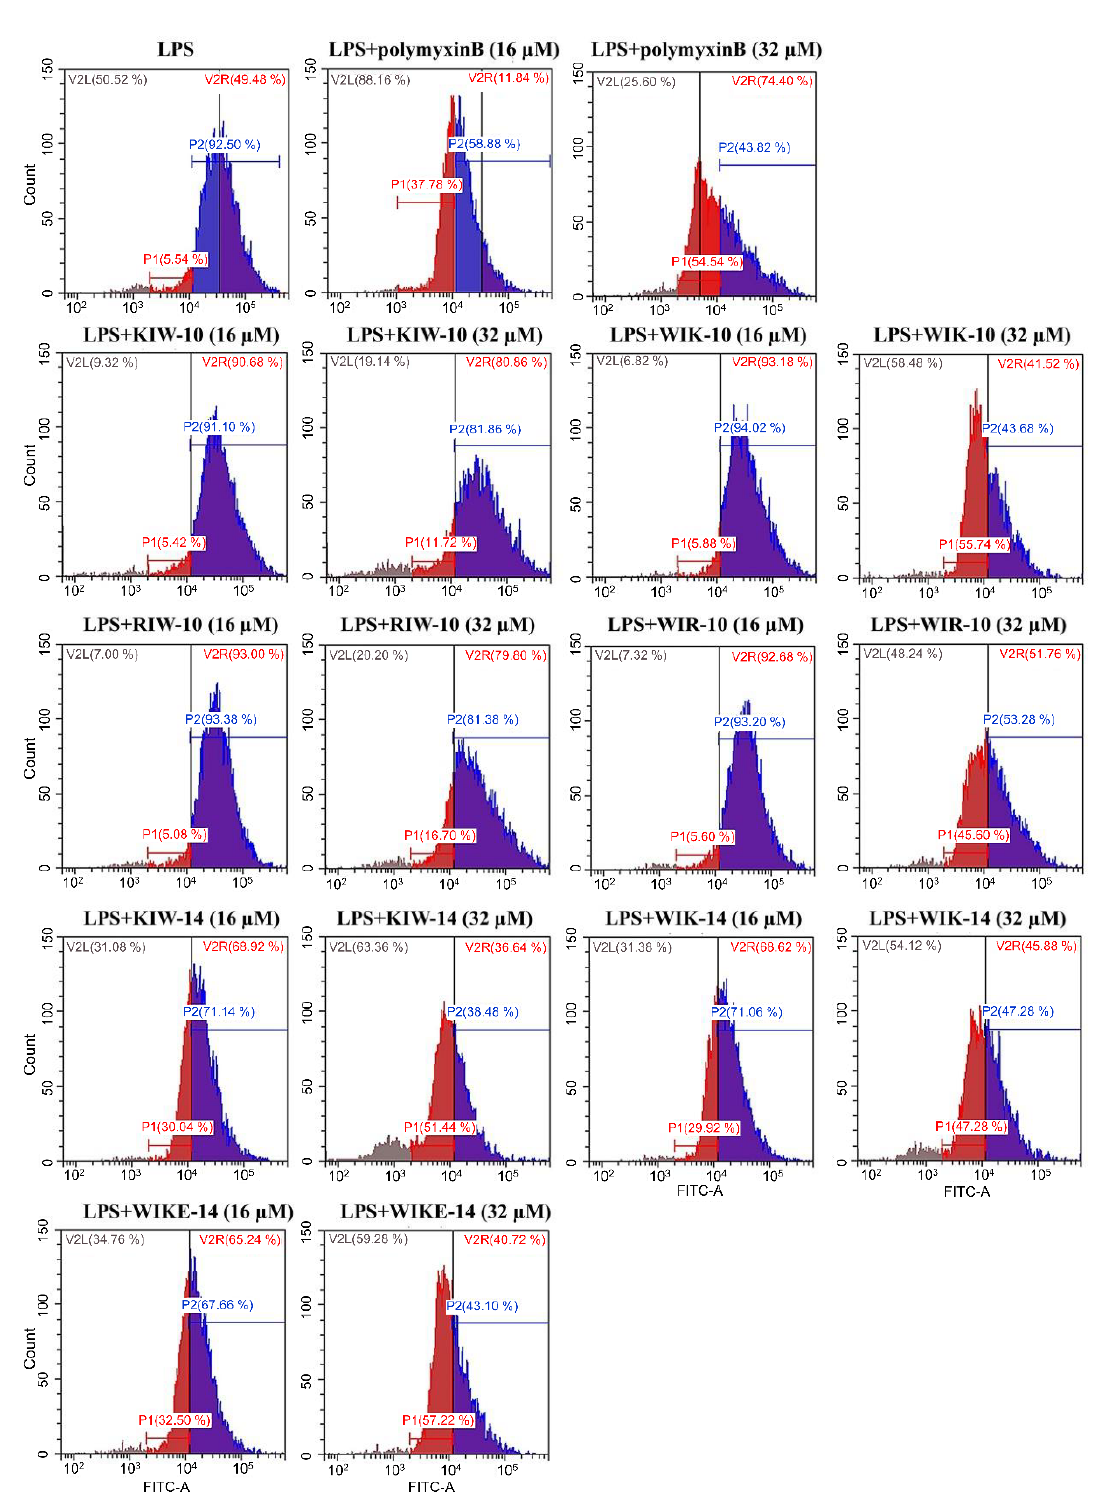
Figure 5. Inhibitory effects of peptides on the binding between LPS and RAW 264.7 cells. FITC- labeled LPS and peptides were incubated for 12 h with RAW 264.7 cells, and cells were washed with PBS, followed by measurement using flow cytometry.